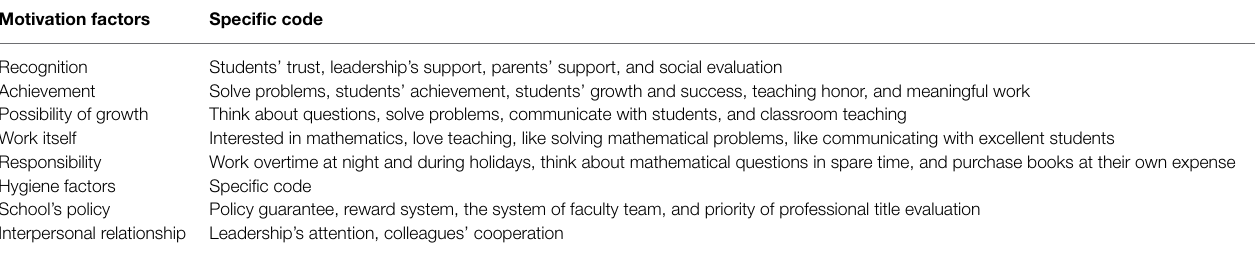
TABLE 3 | Summary of categories and specific